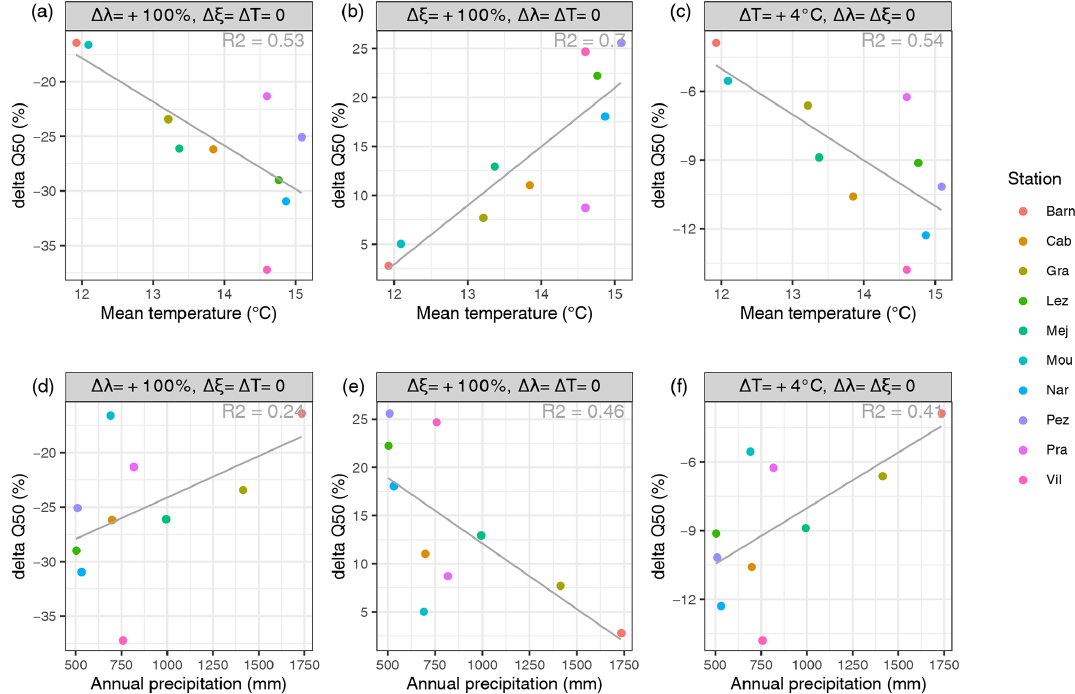
Figure 9. Sensitivity of the median of the simulated soil moisture to precipitation and temperature scenarios ( ξ : precipitation intensity scenario, λ : precipitation intermittence scenario, T : temperature scenario) related to the observed mean annual (a) temperature and (b) pre-